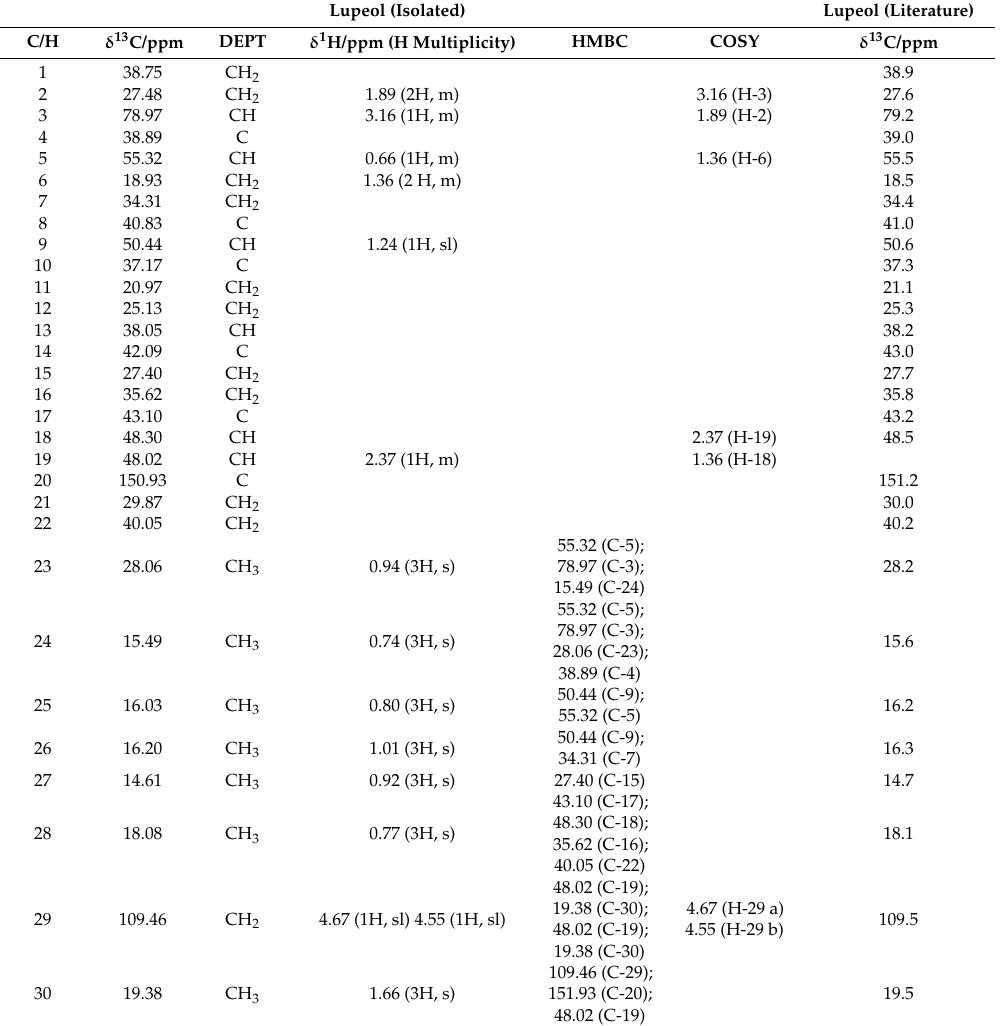
Table A1. 1 H and 13 C-NMR (1D, 2D) spectra data for lupeol isolated from the Bowdichia virgilioides (400 MHz, CDCl 3 ) and 13 C-NMR data